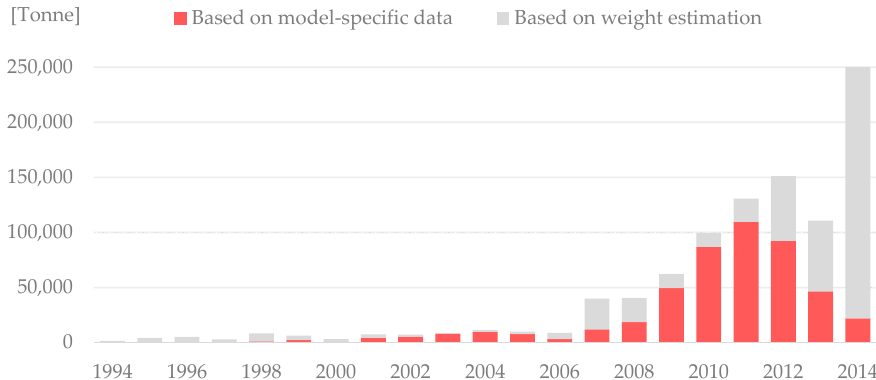
Figure 2. Estimated mass of all turbines installed in Sweden between 1994 and 2014, based on collected data from LCA’s (red bars) and calculated by Equation (2) (grey bars).